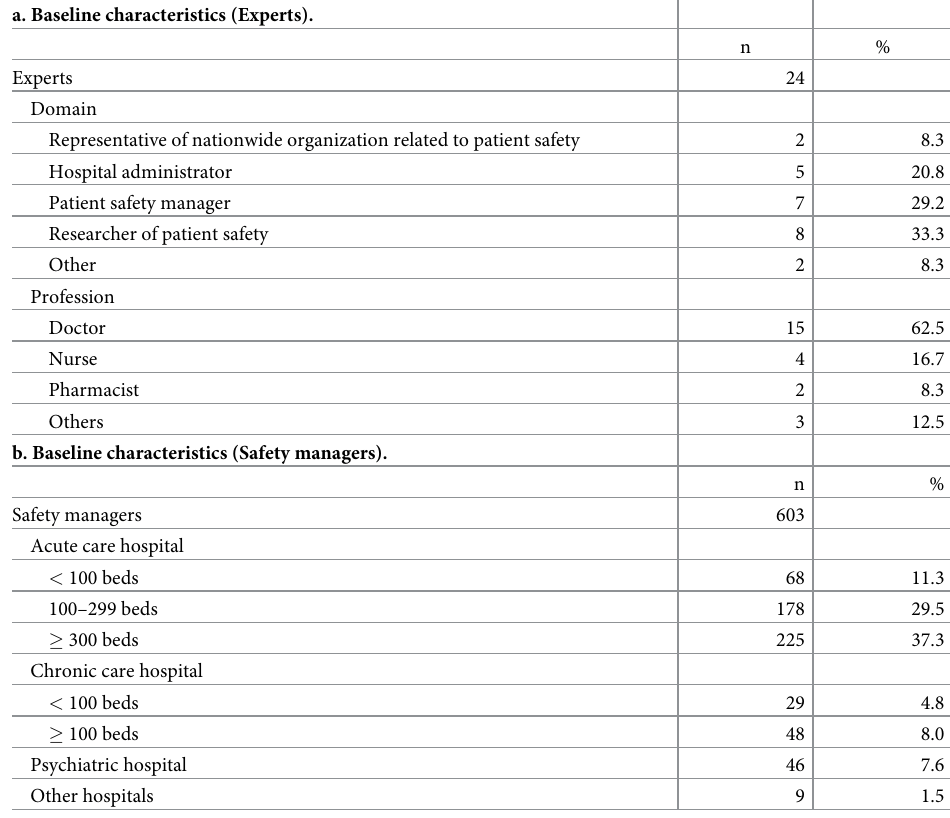
a. Baseline characteristics